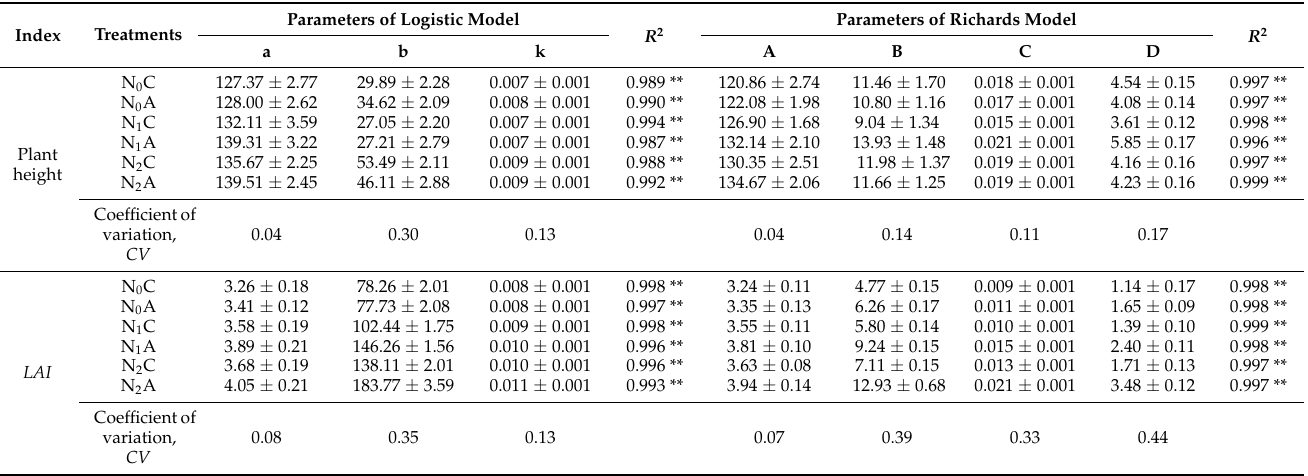
Table 1. Fitting parameters of logistic and Richards models for plant height and LAI dynamics under different treatments.